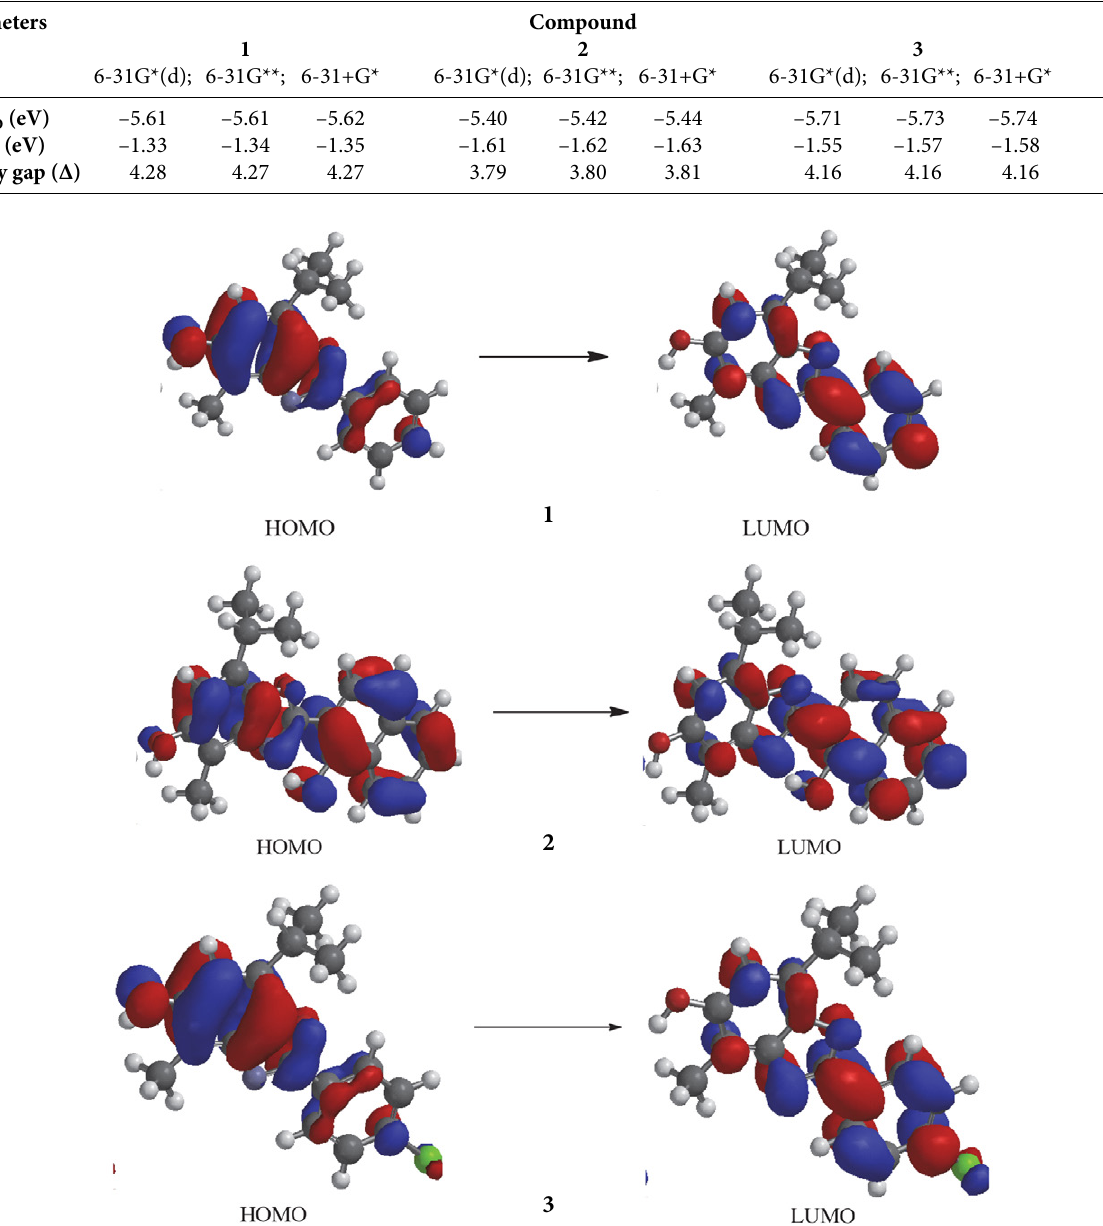
Figure 5. Atomic orbitals of HOMO to LUMO transition of the compounds 1 , 2 and